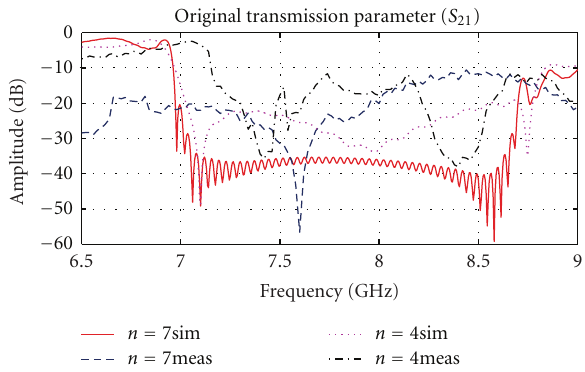
Figure 10: Transmission parameters ( S 21 ) for original